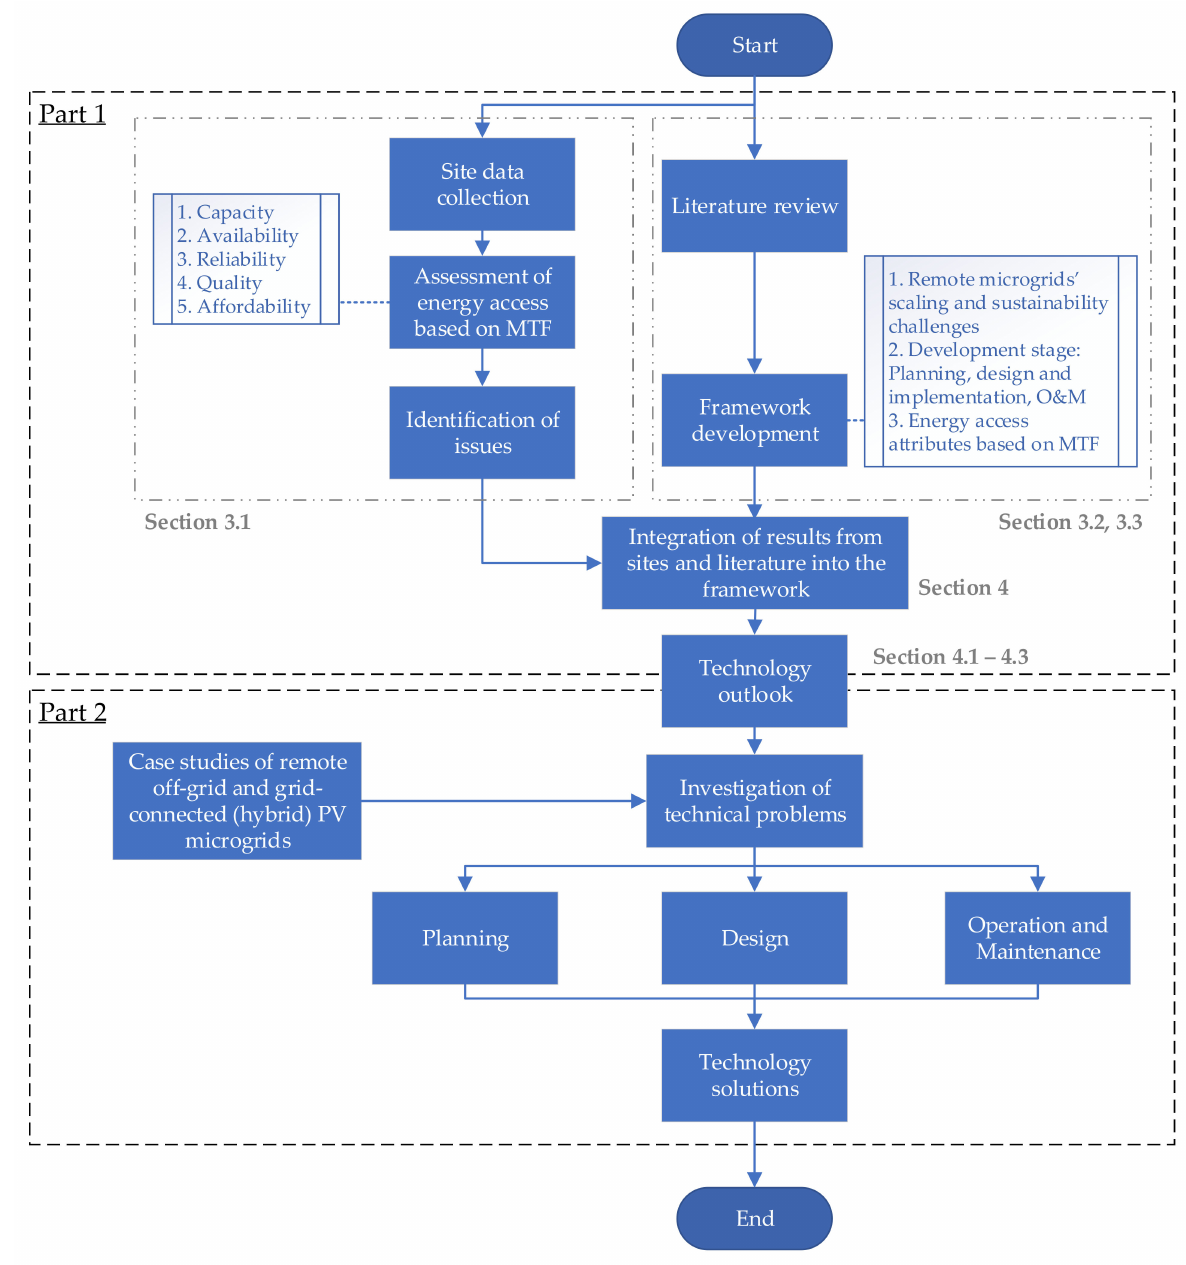
Figure 2. Research